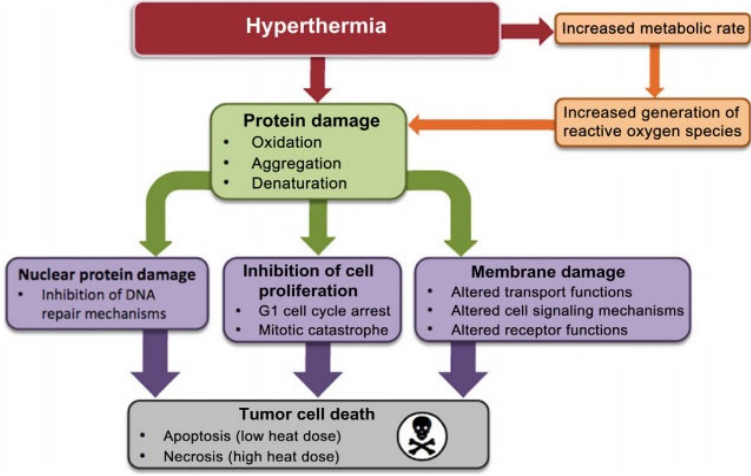
Figure 2. The induced cell changes due to hyperthermia [20].